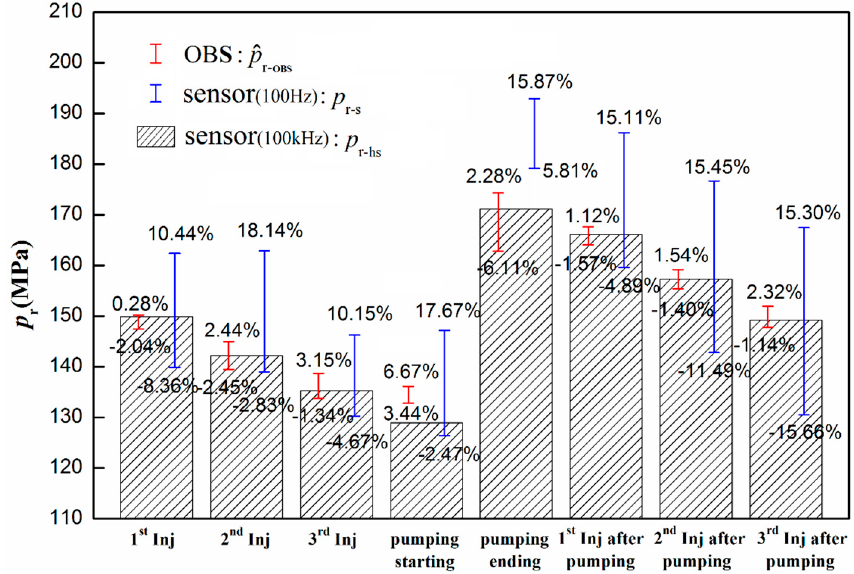
Figure 5. Measured rail pressure error range for (cid:1868)